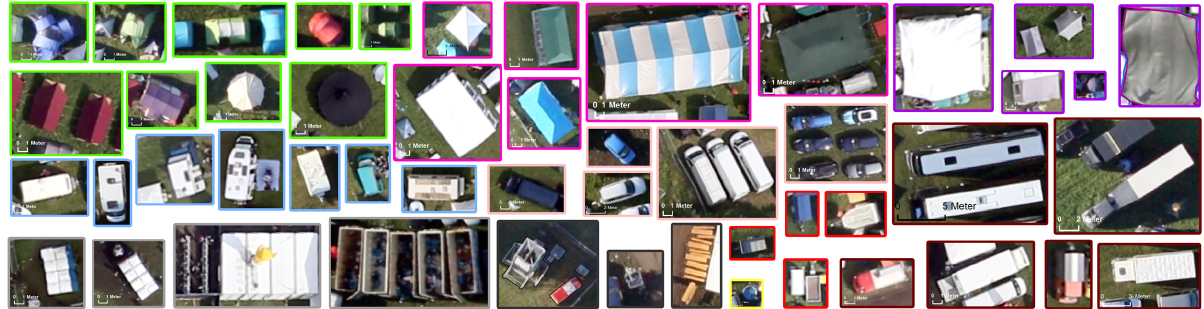
Figure 3. Samples of objects of interests in the DLR-AerialTent dataset which are commonly present in large scale events and camps.